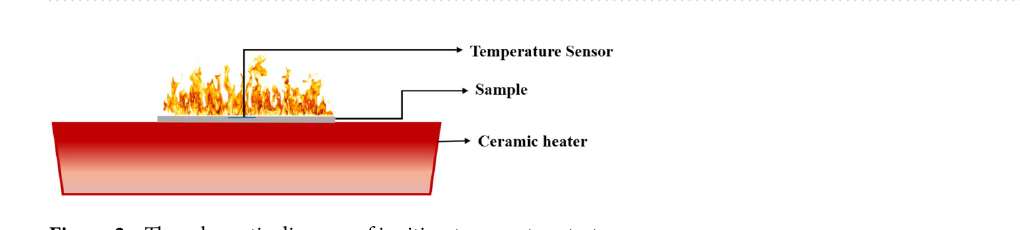
Figure 2. The schematic diagram of ignition temperature